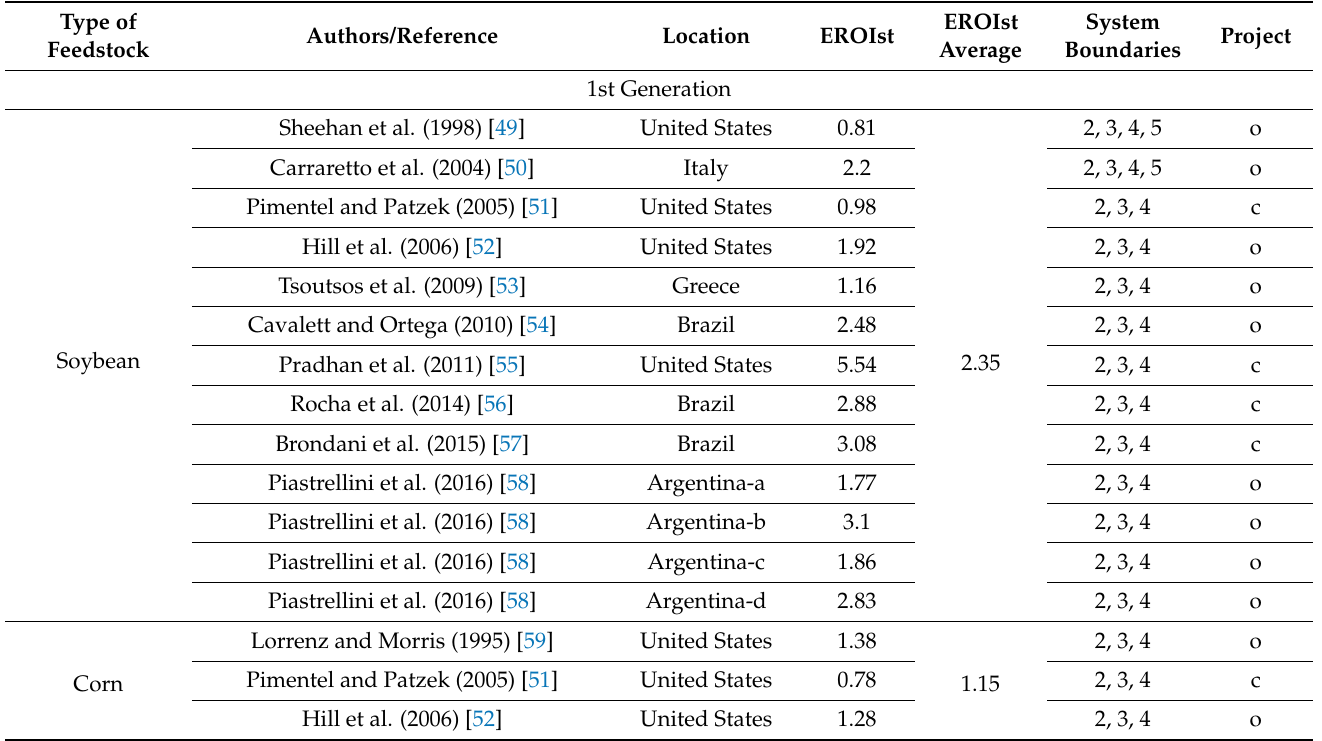
Table 2. Metadata analysis of biofuel